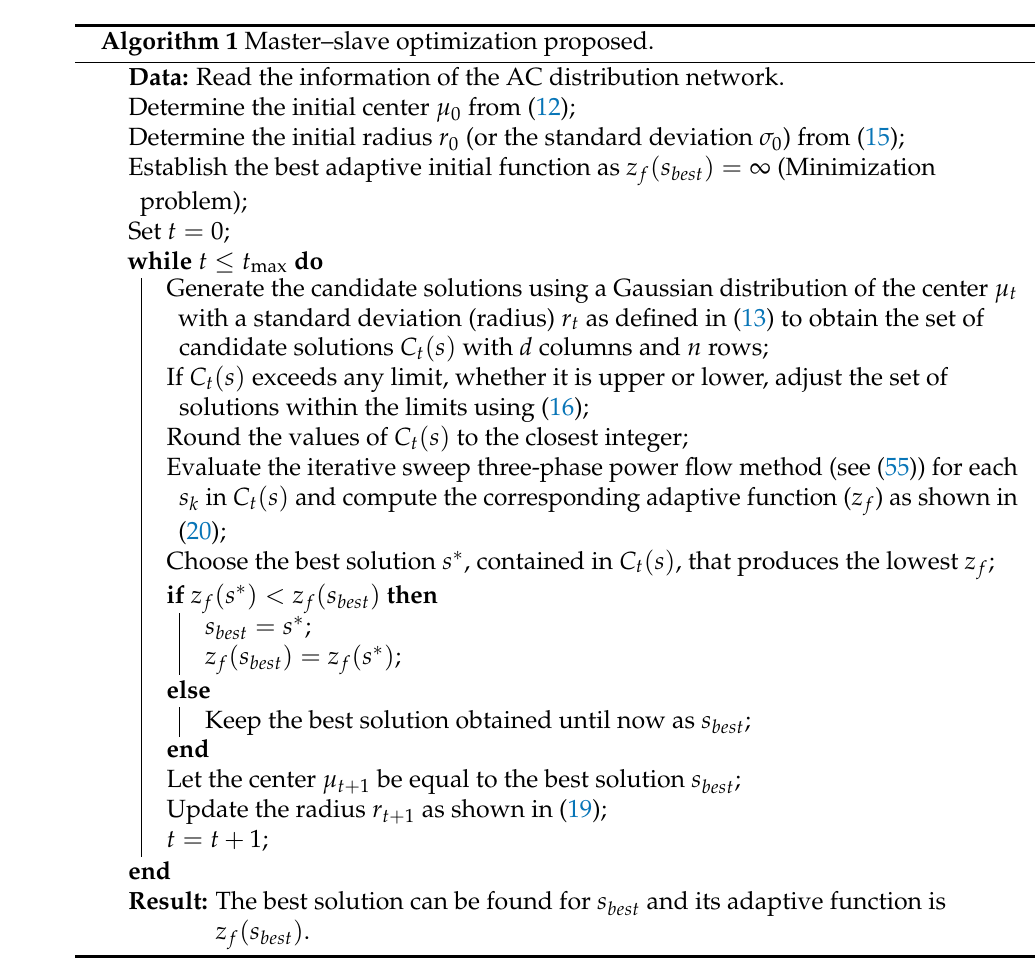
Figure 2. Unbalanced distribution system for the application